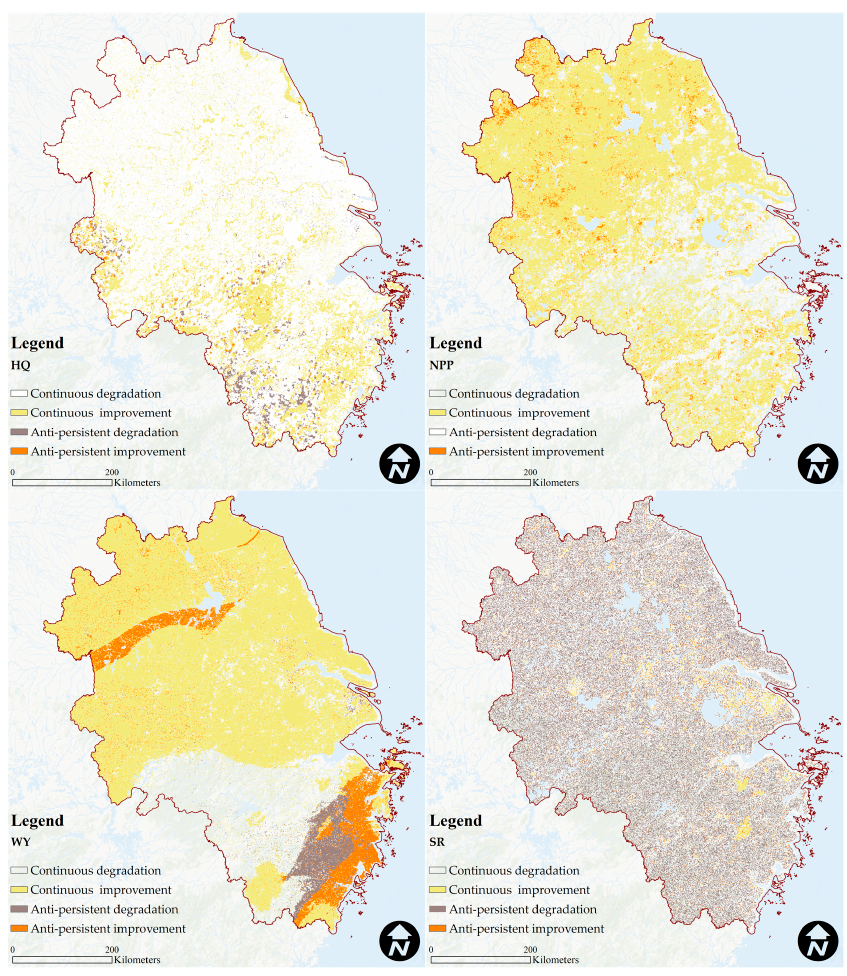
Figure 9. Analysis of the sustainability trend of ecosystem services in the Yangtze River Delta urban